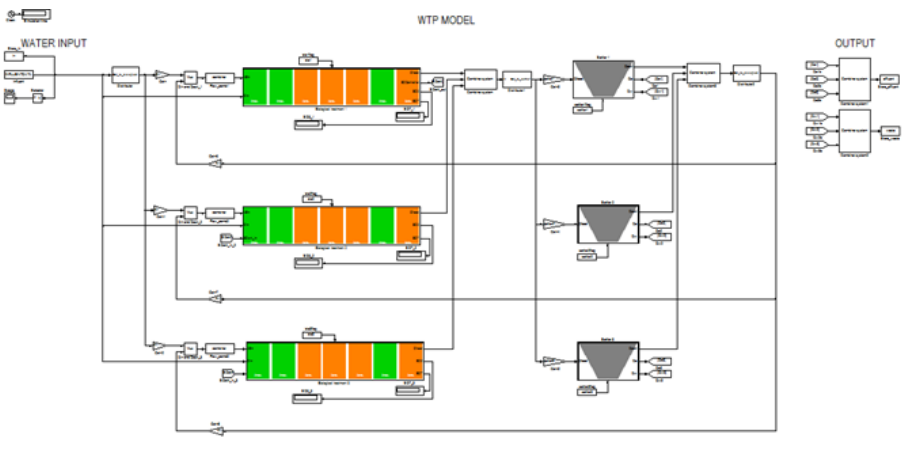
Figure 2. Layout of Girona